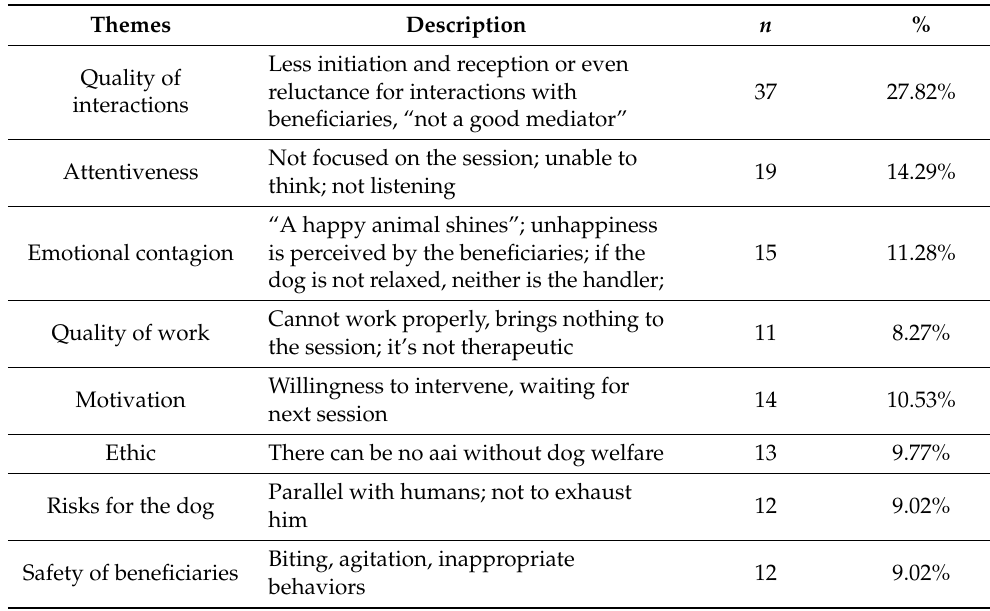
Table 3. This table represents the answers to the question “Do you think that the dog’s well-being plays on a “good” session? If so, why?”. n = 97 complete answers. Total of 133 terms coded grouped into 8 themes; presented in descending order.